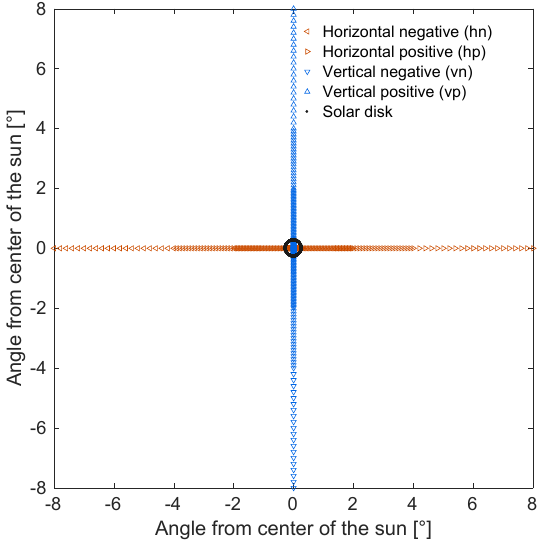
Figure 1. Detector positions in the MC-UniK model cover angles from 0 to − 8 and 8 ◦ from the center of the sun (0, 0 ◦ ). Both horizon- tal and vertical cross sections are divided into positive and negative parts (hp, hn, vp, vn). The circle demonstrates the size of the solar disk, with a diameter of 0.534 ◦